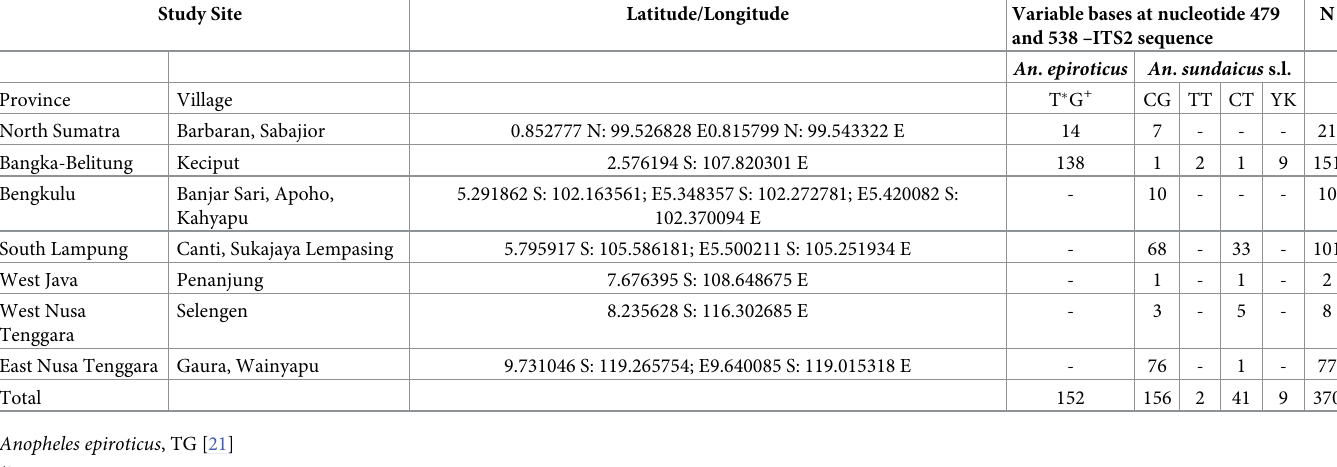
Table 1. Inter-specific variable bases of the ITS2 region that distinguish other Anopheles sundaicus members from Anopheles epiroticus . Study